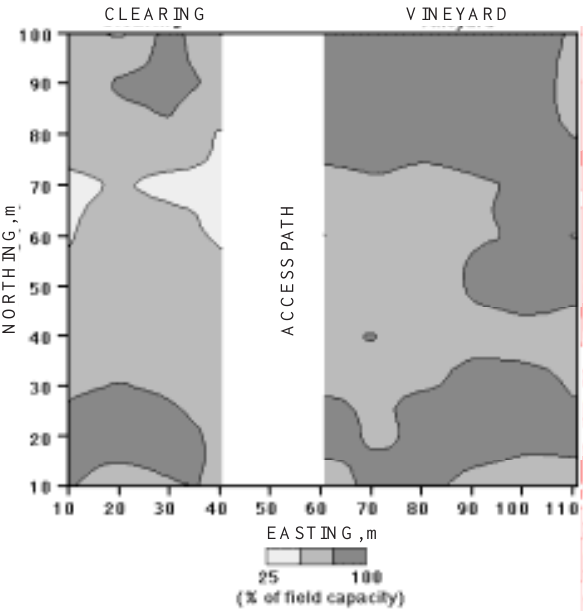
Figure 3. Ratio of actual moisture to field capacity of the Btf2 horizon at time of